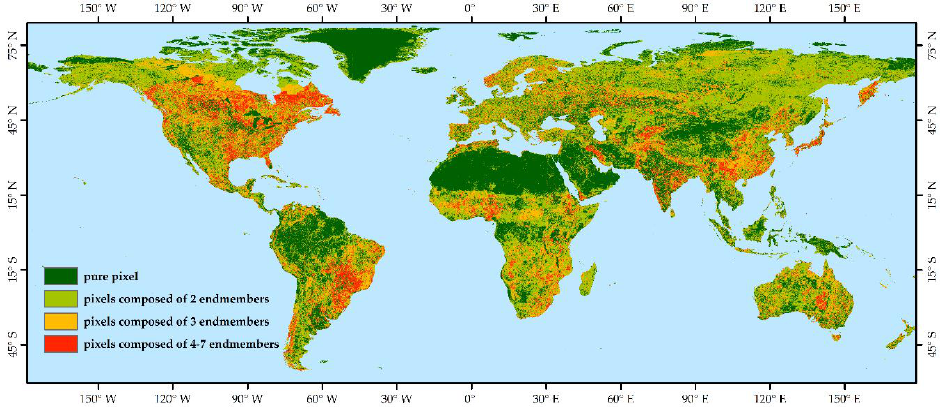
Figure 4. Global distribution of the number of endmembers at a 1-km resolution.